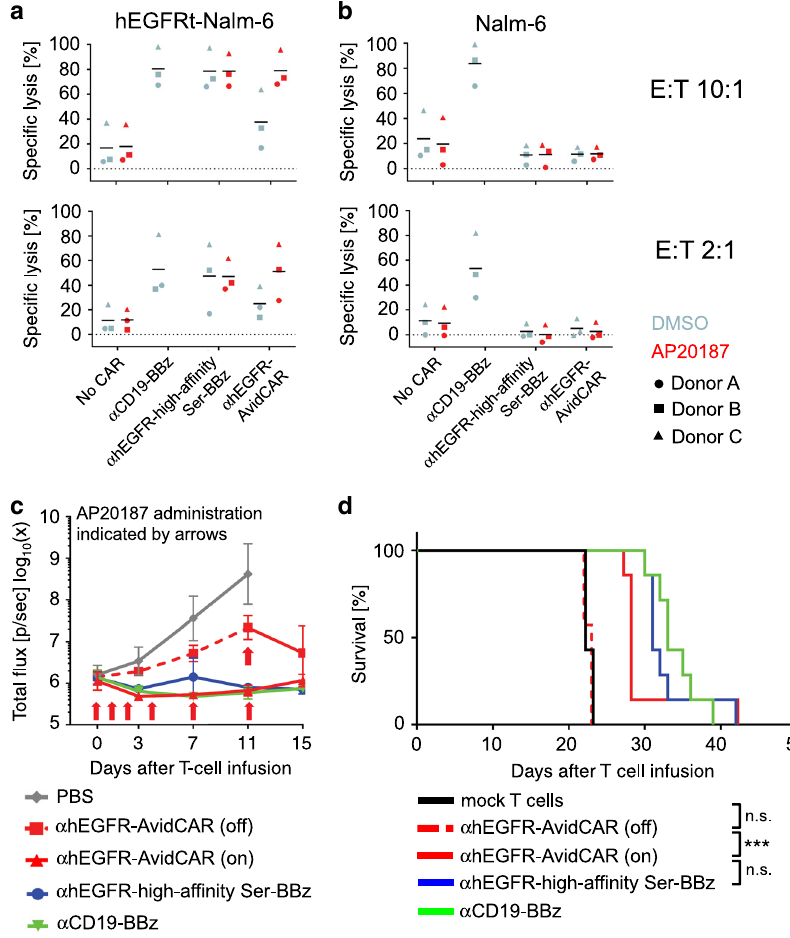
Fig. 5 Regulation of an ON-switch AvidCAR in vivo. a , b In vitro characterization of the lentivirally transduced CAR-T cells and hEGFRt pos Nalm-6 target cells subsequently used in vivo. The hEGFR-speci fi c CARs α hEGFR-high-af fi nity Ser-BBz and α hEGFR-AvidCAR contained either the high- or low-af fi nity rcSso7d binder, respectively, fused to a Ser-BBz backbone with an integrated FKBP12-F36V-domain for CAR homodimerization by AP20187. A CD19- speci fi c CAR ( α CD19-BBz) comprising a high-af fi nity scFv (FMC63) fused to a BBz backbone was included as a benchmark (SEQ-ID 19). The diagrams show the cytolytic activity of mock-T cells (no CAR) and different CAR-T cells in co-cultures with Nalm-6 cells ± hEGFRt expression (Luciferase-based assay; E:T ratio 10:1 or 2:1, as indicated; one experiment with three different donors). AP20187 was added where indicated. c Bioluminescence imaging of Nalm-6 cells over time in NSG mice. Three days after intravenous injection of 0.5 × 10 6 hEGFRt-Nalm-6 cells, mice were intravenously injected with 10 × 10 6 CAR-T cells or PBS (one experiment with fi ve mice per group, in the α EGFR-high-af fi nity Ser-BBz group one mouse died 1 day after tumor injection). Mice which received the α hEGFR-AvidCAR-T cells were intraperitoneally injected with AP20187 (indicated by arrows) either starting from the day of T-cell injection ( α hEGFR-AvidCAR on) or only once on day 11 thereafter ( α hEGFR-AvidCAR off). Data are presented as geometric means± geometric SD. d ON- switch AvidCAR-T cells prolong survival. NSG mice were injected via tail vein with 0.5 × 10 6 hEGFRt-Nalm-6 cells and 3 days later with 10 × 10 6 CAR-T cells or mock-T cells, as indicated. Mice were intraperitoneally injected three times a week starting from the day of T-cell injection either with 2 mg/kg AP20187 ( α hEGFR-AvidCAR group) or vehicle solution (all other groups). Kaplan – Meier plot shows the survival of seven mice per group (*** p < 0.001, calculated by a two-sided log-rank analysis). Exact p values are given in Supplementary Data 2. Source data are provided as a Source data fi